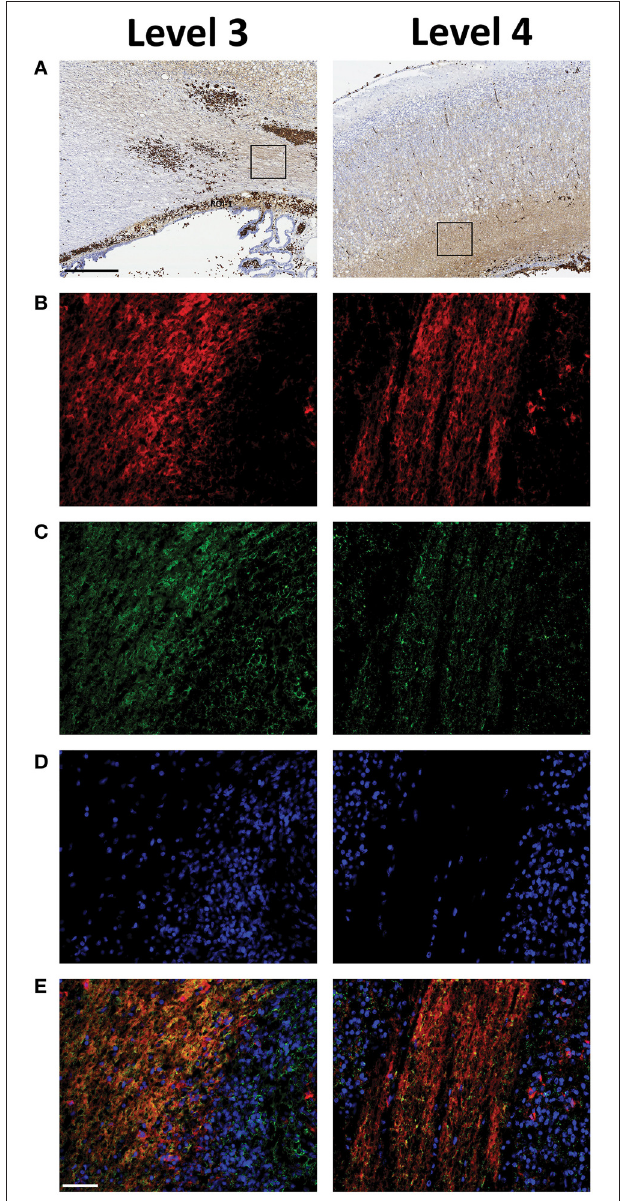
FIGURE 5 | Extracellular Hb is present within plastic areas of the periventricular white matter following preterm rabbit pup IVH. The relation between Hb (B) , displayed in red and PSA-NCAM (C) , displayed in green, a marker of areas with high plasticity, characterized by double labeling of selected regions of interests (ROI) of peroxidase activity corresponding areas (A) , recorded in parallel sections. Rabbit pups with IVH or sham controls were euthanized at 72h of age followed by saline and freshly prepared 4% PFA perfusion. Afterwards the brains were dissected from the skulls and immersed in 4% PFA. Brains were prepared and sections at the levels of rostral midbrain (Level 3) and caudal midbrain (Level 4), were immunolabeled for Hb and PSA-NCAM as described in the Materials and Methods section. DAPI labeled cell nuclei, displayed in blue, are shown in (D) and the merge of Hb, PSA-NCAM and DAPI is displayed in (E) . Fluorescence microscope analyses were performed on a wide-field Olympus microscope (IX73) and slide scanning were performed on a Hamamatsu NanoZoomer 2.0-HT Digital slide (Continued)